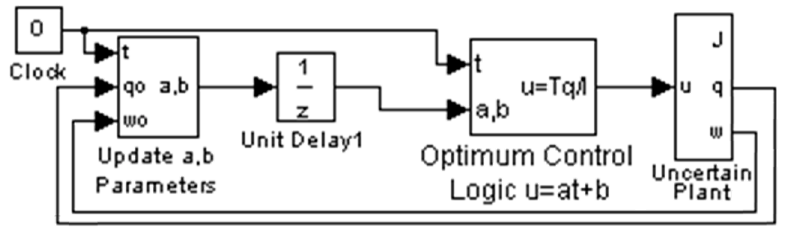
Figure 5. Time ‐ delay inserted before control logic. Figure 5. Time-delay inserted before control